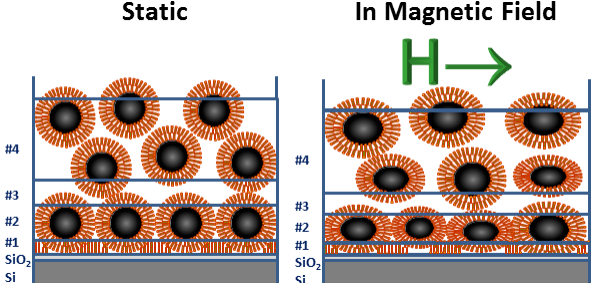
Figure 7. Schematics showing the layers that form in static and magnetic fields for a FF in direct contact with a SiO 2 hydrophilic surface. As detailed in the text, layer # 1 is primarily composed of ligands, whereas layer # 2 mostly has close-packed NP cores. Layer # 3 is similar to # 1 but with more evidence of disorder. The NPs are assumed to be spherical in the static model (left). The magnetic field model (right) depicts elongated NPs with long axes that align parallel to the in-plane magnetic field